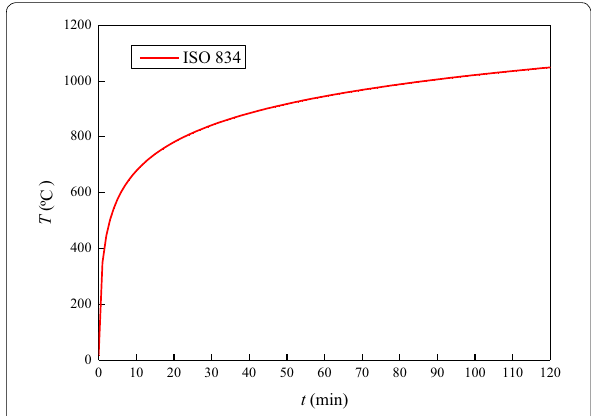
Fig. 1 The standard fire curve specified in ISO